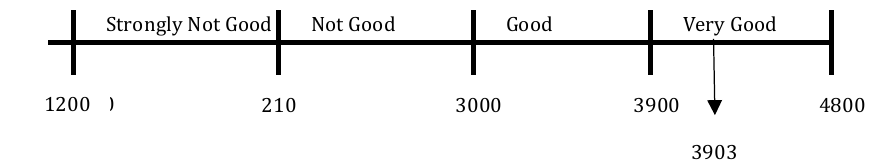
Fig. 2 Continuum Lines for Millennial Tourist Decisions on Tourism Attractions in West Bandung Regency Based on the recapitulation and continuum lines of the tourist visiting decision variables above, it can be concluded that the overall response of respondents regarding the decision to visit millennial tourists on tourist attractions in West Bandung Regency which includes cultural, personal, social, and psychological factors which are in the good